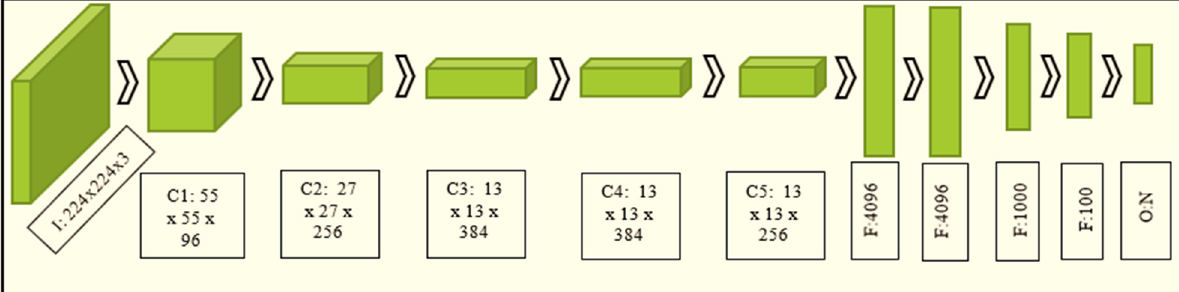
Figure 8. AlexNet-based architecture used in the experiment: I: input, C: convolutional layer, F: fully connected later, O: output layer with softmax classifier, N: the total number of the class.